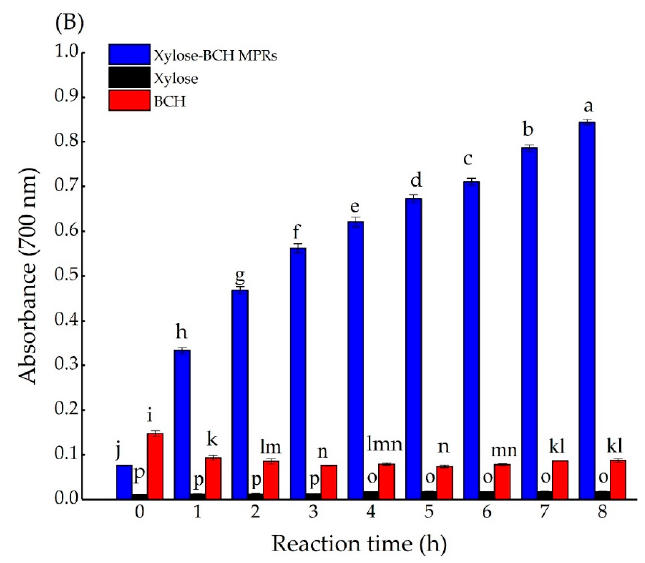
Figure A6. Effects of the reaction time on 2,2-diphenyl-1-picryl-hydrazyl (DPPH) free radical scavenging capacity ( A ) and on ferrous reducing activity ( B ) of xylose–BCH MRPs, BCH, and xylose samples. Effects of reaction time on absorbance at 700 nm of xylose–BCH MRPs, BCH, and xylose ( B ). The standard deviation is showed by error bars. Data points with diverse letters are significantly different ( p < 0.05).